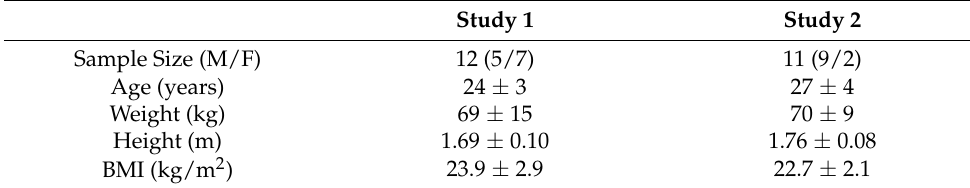
Table 1. Characteristics of participants in the two studies.